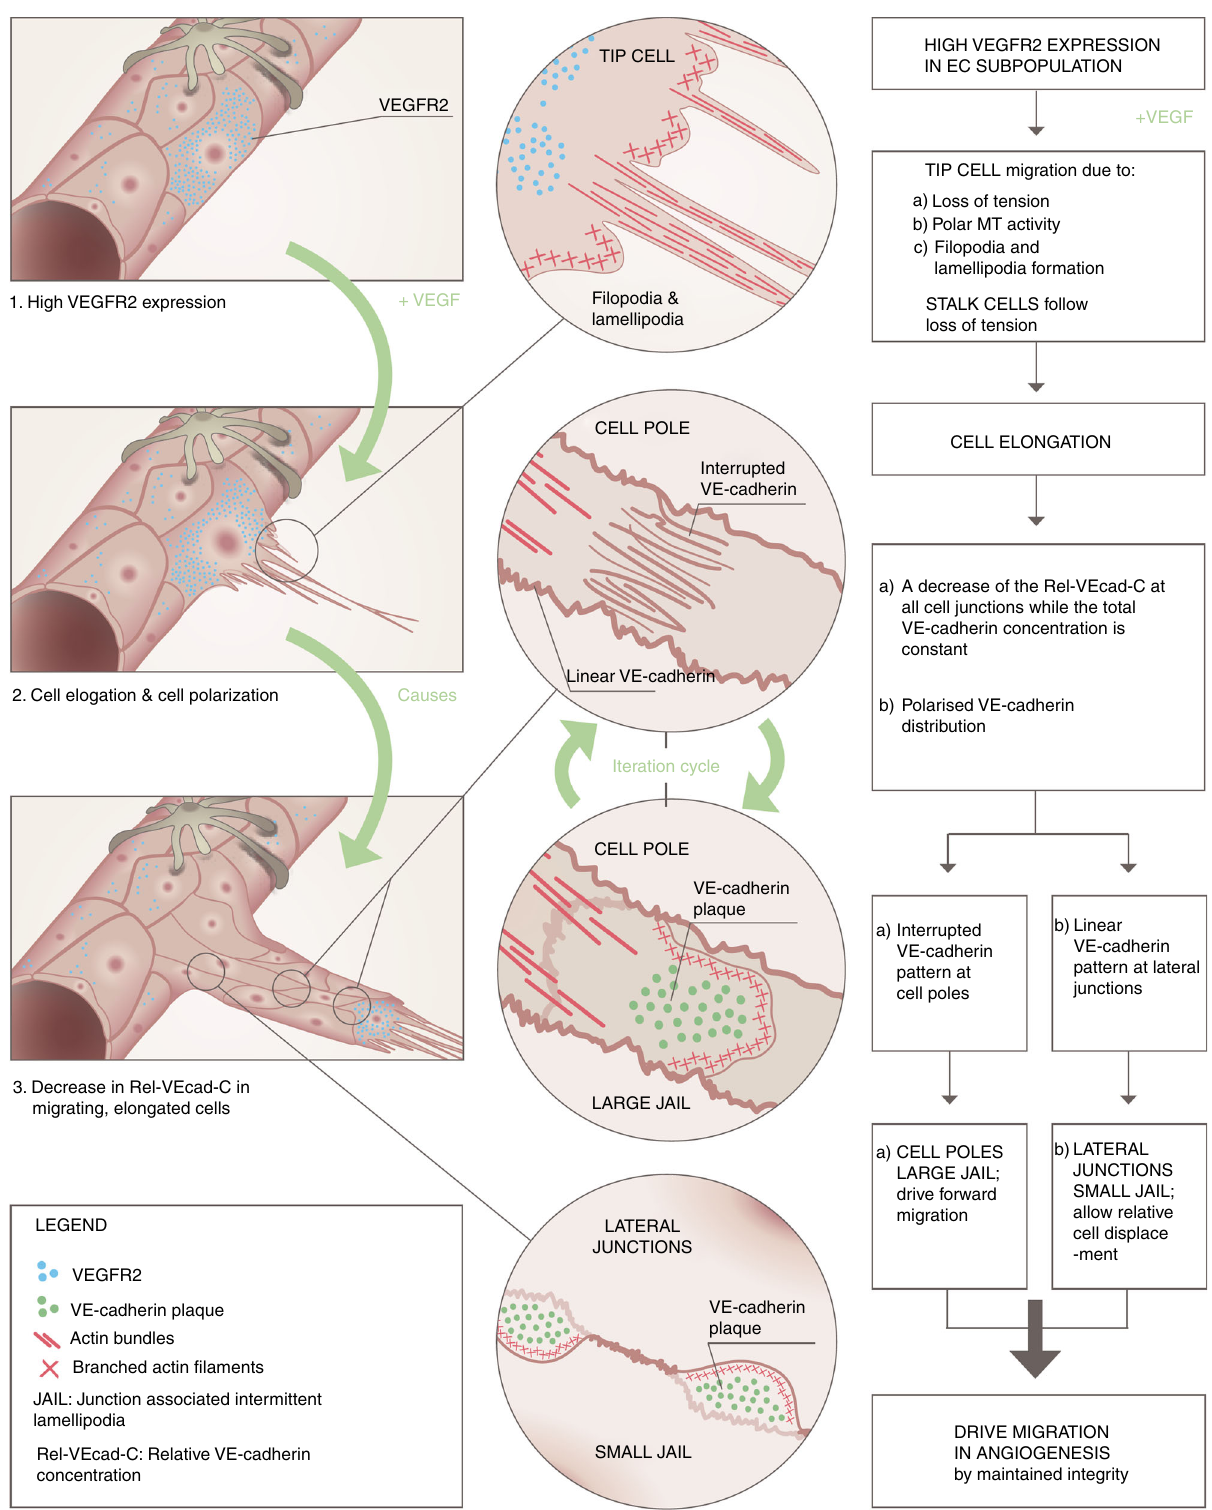
Fig. 10 The scheme illustrates the proposed model of the molecular mechanisms driving cell migration in